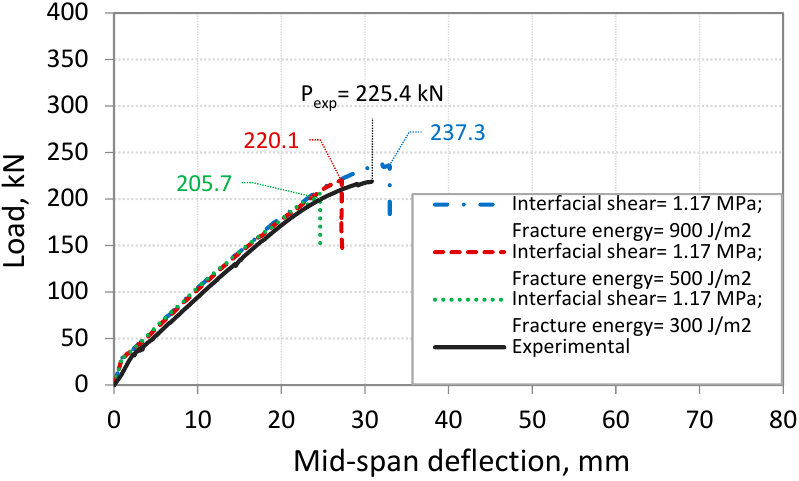
Figure 10. Comparison between experimental and FE results for different values of G cr .